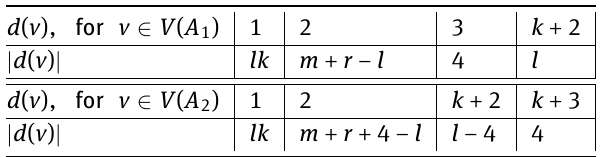
Table 1: Vertex-partitions of the tricyclic graphs A 1 and A 2 .